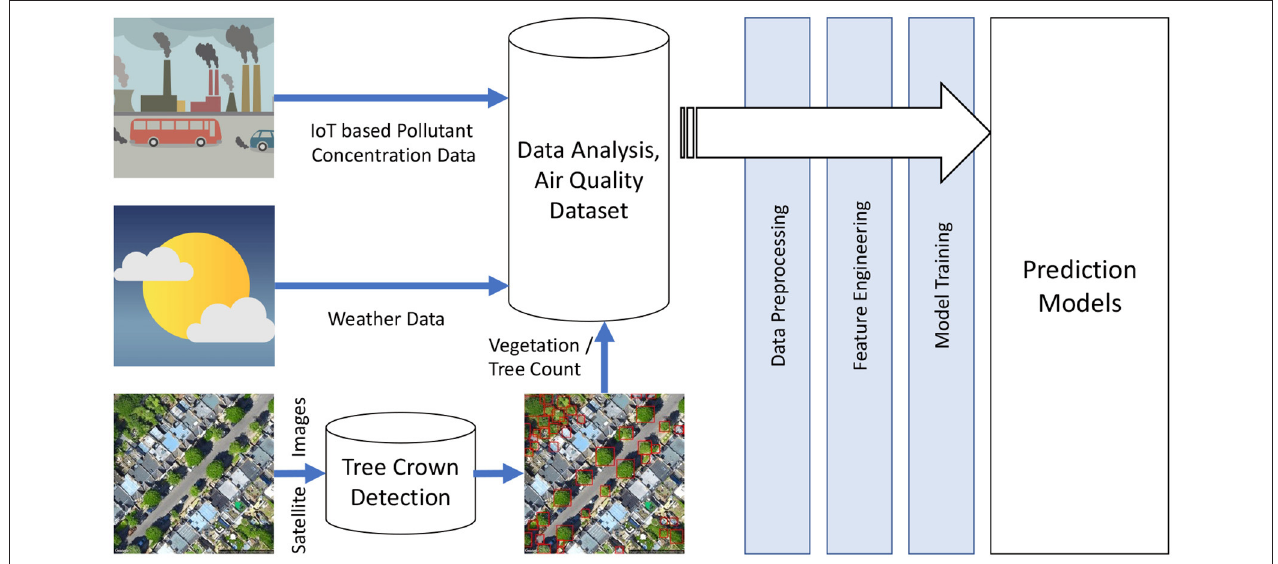
FIGURE 5 | AirQuality framework: modeling pollutant concentration with weather and vegetation.